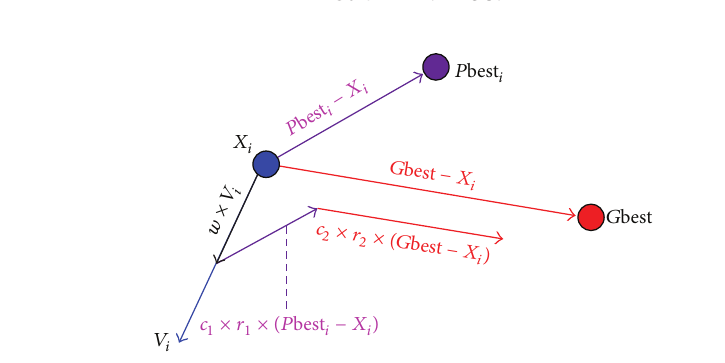
Figure 1: Cognition and social terms in PSO.